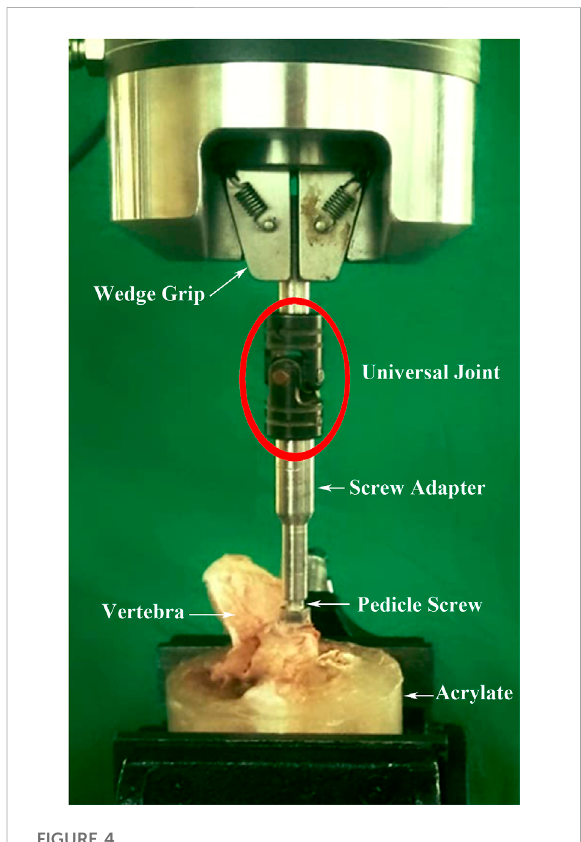
Experimental setup of the screw pullout test of the single vertebrae. The screw head was fi xed to one end of an adapter having an inner thread that matched the outer thread of the screw head. The other end of the adapter was then clamped to the upper wedge grip of the MTS testing machine. The adapter equipped with a universal joint ensuring vertical pullout alignment during the pullout